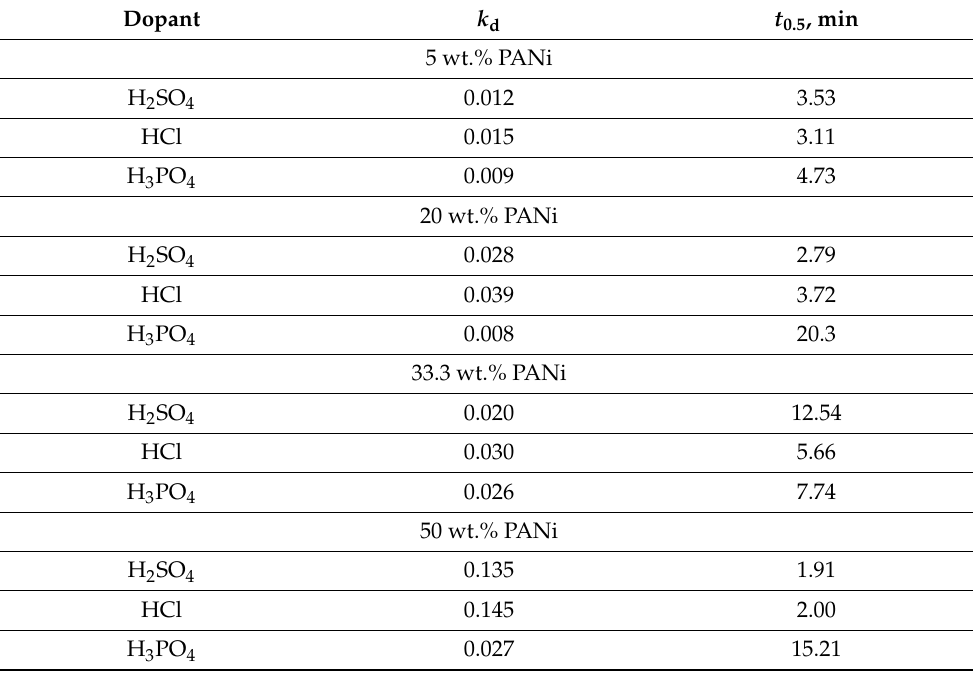
Table 3. Dispersibility of core/shell pigment with PANi shell doped with various acids. Dopant k d t 0.5 , min 5 wt.% PANi